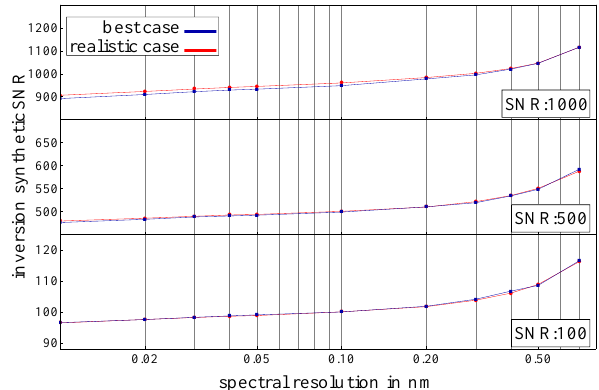
Figure 8. Mean synthetic signal to noise level from inversion at- tempts vs. spectral resolution for three prescribed SNR levels. Blue lines indicate the best case setup, whereas results for the realistic case are shown using red color. Spectral sampling is equal to the spectral resolution. The best case is characterized by a homoge- neous surface and known aerosol model, where the realistic case is characterized by an unknown aerosol model and a heterogeneous surface